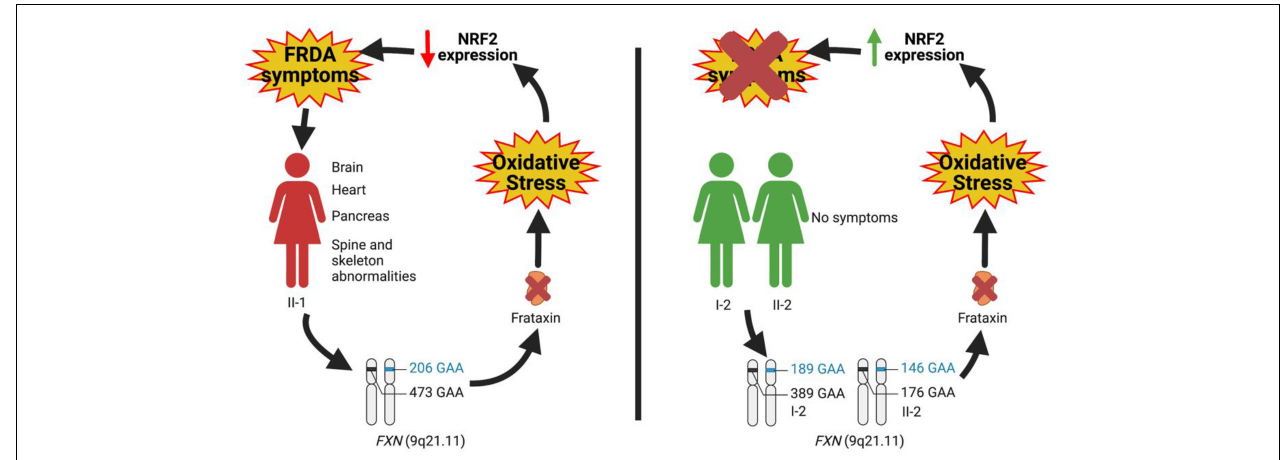
FIGURE 4 | Hypothesis on the role of nuclear factor erythroid 2-related factor 2 (NRF2) as a protective factor antagonizing the insurgence of Friedreich’s ataxia (FRDA) symptomatology.